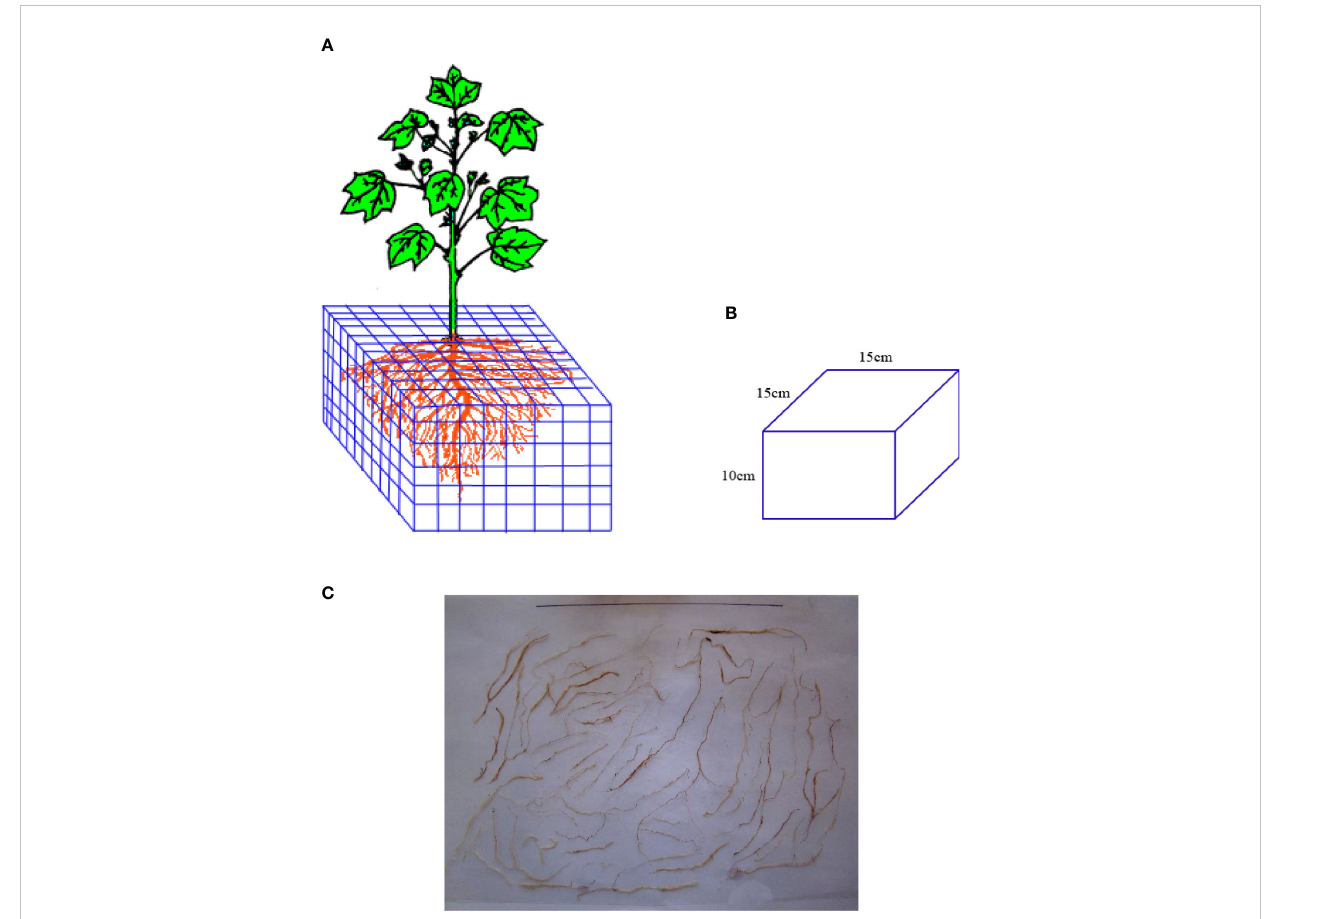
FIGURE 2 Methods for root imagens analyses. (A) Schematic diagram of sampling and sectioning. (B) Soil sample after slicing. (C) Root samples with scaled paper for taking pictures.